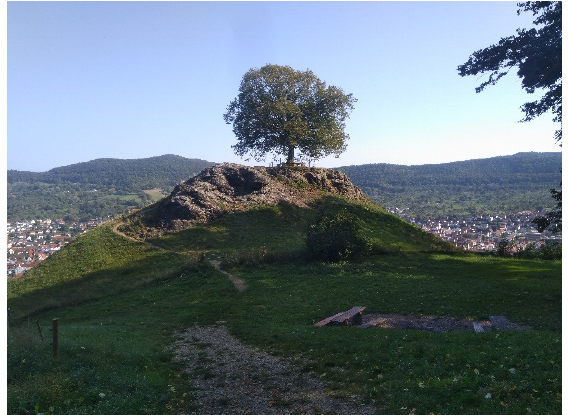
Figure 4. Tertiary volcanic vent Calver Bühl. Not recognizable as such by a lay audience (UGGp Swabian Alb, Germany)(Megerle 2020).